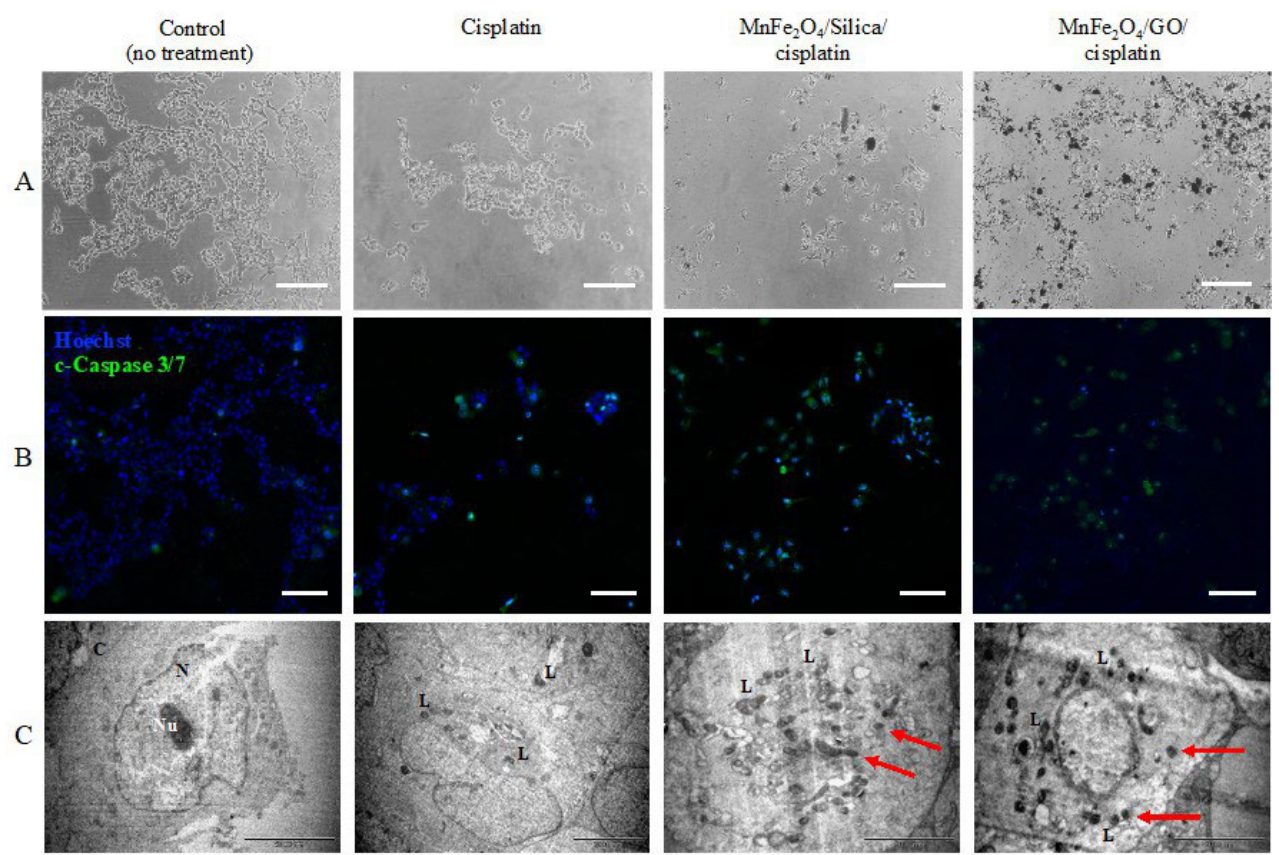
Figure 8. Apoptotic effect of different treatment conditions on MCF7. Cells were treated with cisplatin, MnFe 2 O 4 /silica/cisplatin, and MnFe 2 O 4 /GO/cisplatin for 48 h. The highest dose of each condition was used as follows: cisplatin was 0.0225 mg/mL; MnFe 2 O 4 /silica/cisplatin, and MnFe 2 O 4 /GO/cisplatin was 0.5 mg/m: ( A ) brightfield images (scale bar is 200 µ m); ( B ) immunoflu- orescence images of cells stained with cleaved-Caspase 3/7 (green) and Hoechst (blue) (scale bar is 100 µ m); and ( C ) TEM images of treated cells (scale bar is 5 µ m). N: nucleus; Nu: nucleolus; Cy: cytoplasm; L: lysosome vacuoles: red arrow: Nanoparticle penetration. Images in A and B are not from the same field of